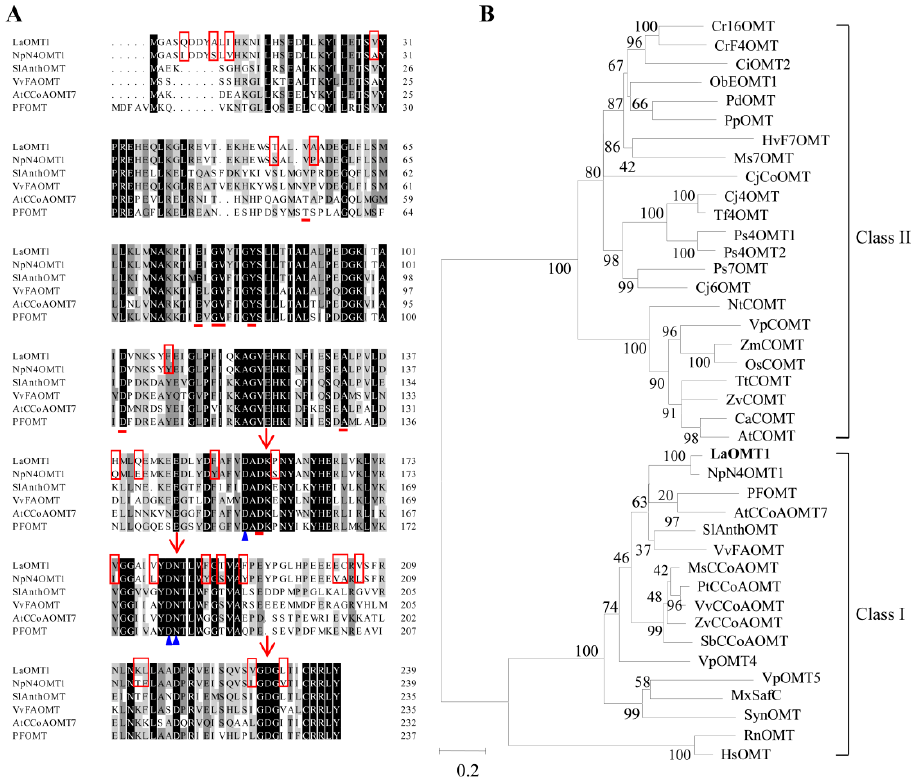
Figure 1. Sequence analysis of LaOMT1. ( A ) Protein sequence alignment of LaOMT1 with homologous proteins from other species. Amino acids shaded in black are identical, those in dark and light grey are similar. Amino acids involved in interactions with a methyl group donor S -adenosyl- L -methionine (SAM) are marked with red lines. Amino acids involved in interactions with metal ions are marked with blue triangle, and amino acids involved in the catalysis of the methyl transfer are marked with red arrows. The different amino acid residues between LaOMT1 and NpN4OMT1 are indicated as red frames. ( B ) Phylogenetic analysis of LaOMT1 and other OMTs. Alignment of sequence was performed with Clustal Omega, and the phylogenetic tree was constructed with MEGA version 5.2 (http://www.megasoftware.net) using the maximum-likelihood method with 1000 replicate bootstrap support. The characterized OMTs from different species were listed in Table S2. Numbers at the nodes indicate the percent bootstrap values. The bar at bottom shows 0.2 amino acid substitution. The LaOMT1 is highlighted in